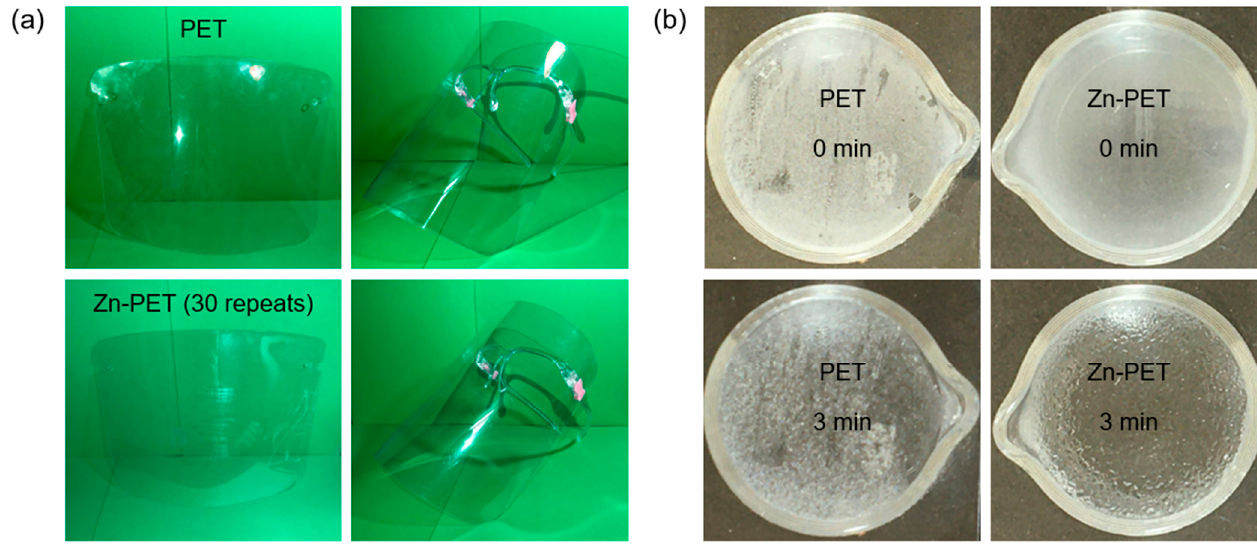
Figure 8. Images of the PET and Zn-PET (30 repeats) face shields ( a ) and images of water vapor fogging of the PET and Zn-PET films at 0 and 3 min ( b ).